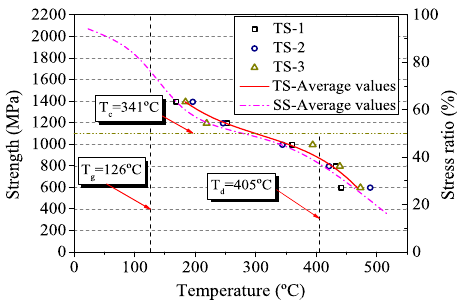
Figure 8. Variation of failure temperatures with target loads in transient state tests.